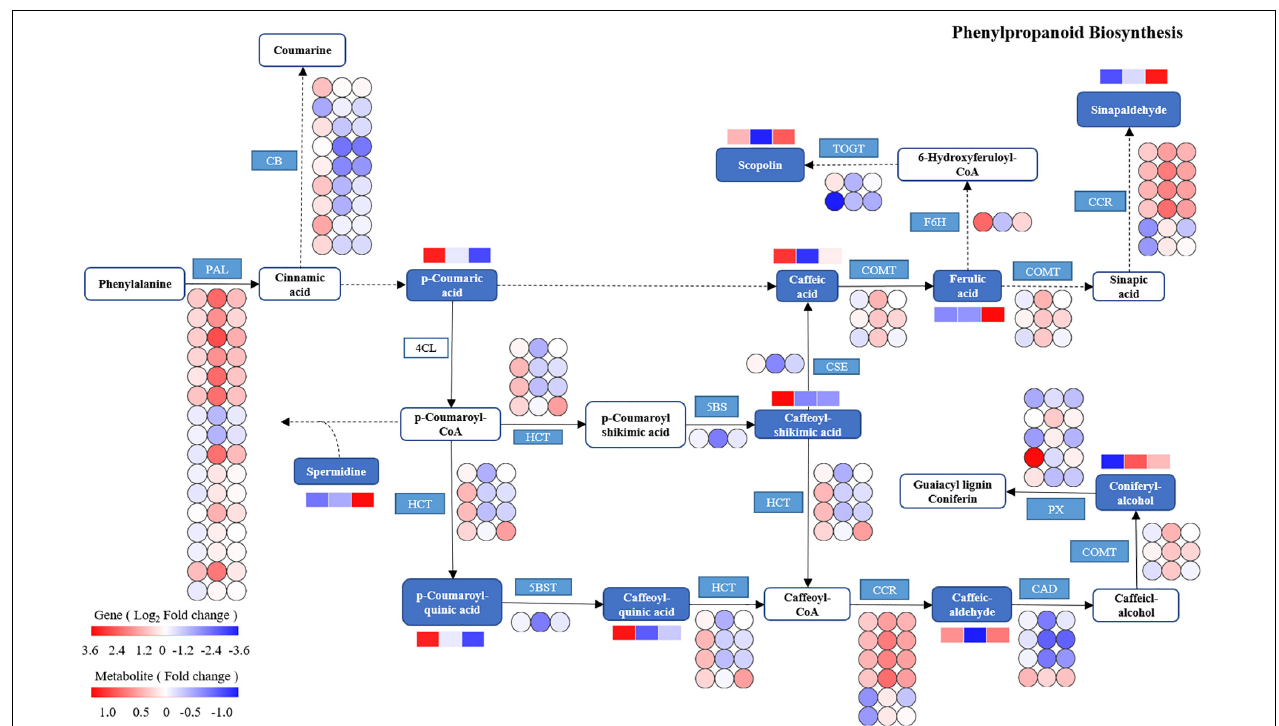
FIGURE 10 | The DEGs and DEMs involved in the phenylpropanoid biosynthesis pathway in response to cold stress. The blue pattern represents the metabolites or genes that changed under CK, TH-0%, and TH-75% groups. The rectangle is divided into three equal parts (the left of the rectangle represents DEGs or DEMs in CK, the middle of the rectangle represents DEGs or DEMs in TH-0%, and the right of the rectangle represents DEGs or DEMs in TH-75%). The color in the rectangle indicates that the genes or metabolites were regulated (red indicates upregulation and blue indicates downregulation). AtBG1: beta-glucosidase; PAL: phenylalanine ammonia-lyase; CCR: cinnamoyl-CoA reductase; PX: peroxidase; HCT: shikimate O -hydroxy cinnamoyl transferase; TOGT1: scopoletin glucosyltransferase; F6H: feruloyl-CoA 6-hydroxylase; CSE: caffeoyl shikimate esterase; 5BST: 5 -O- (4-coumaroyl)- D -quinate 3 (cid:48) -monooxygenase; CAD: cinnamyl-alcohol dehydrogenase; and COMT: caffeic acid 3- O